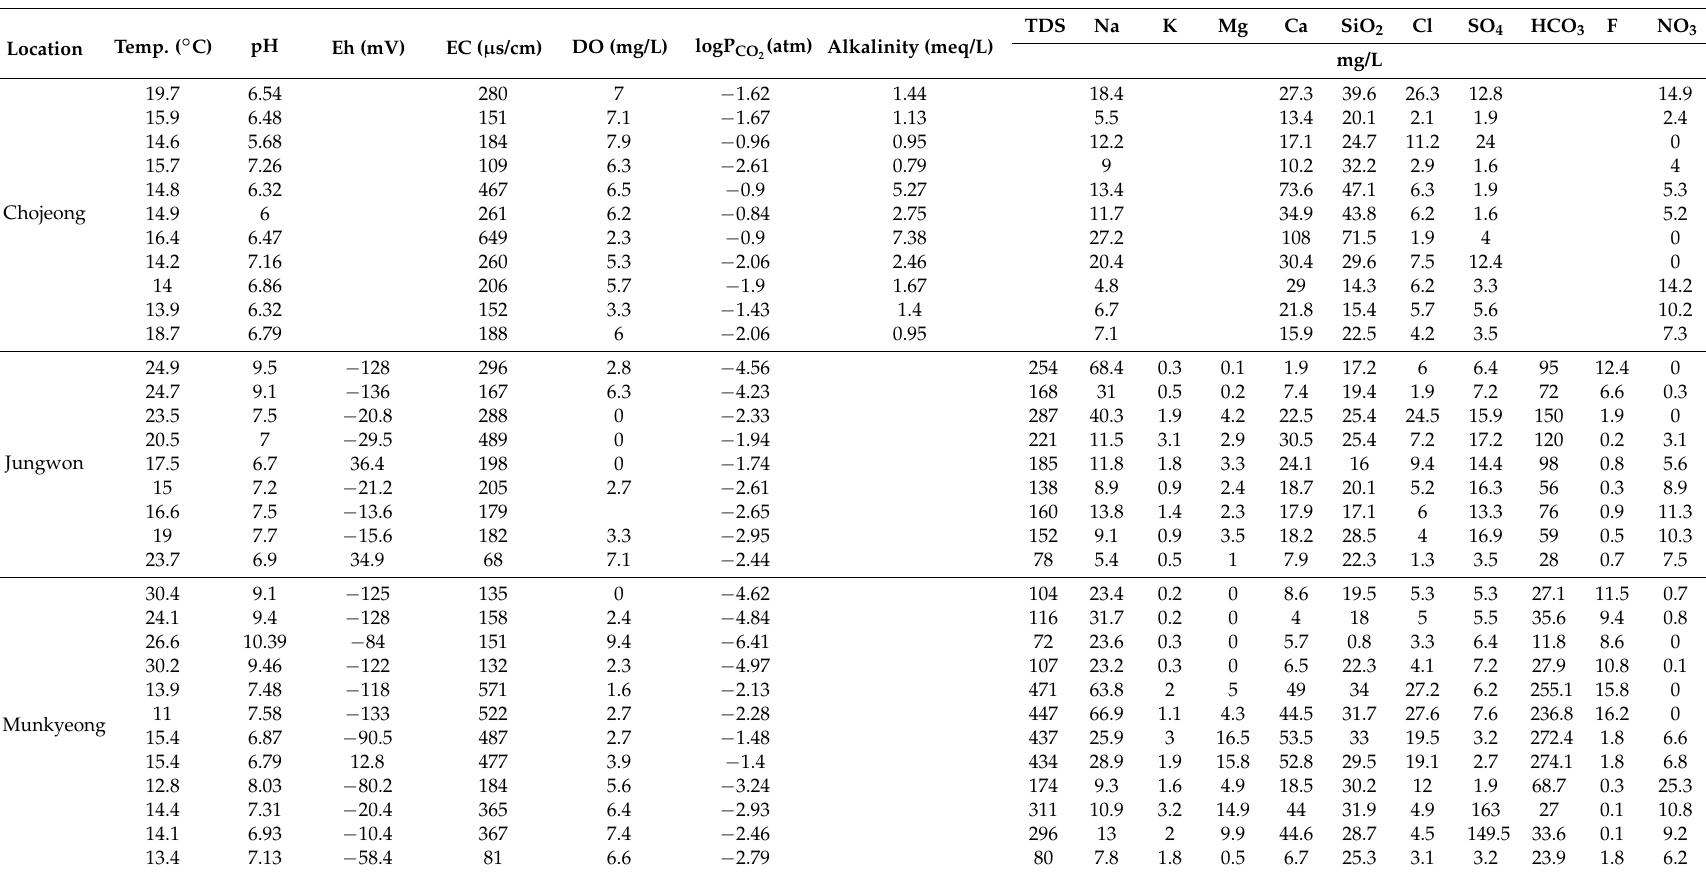
Table 9. Geochemical data of CO 2 -rich water samples from Chungcheong Province